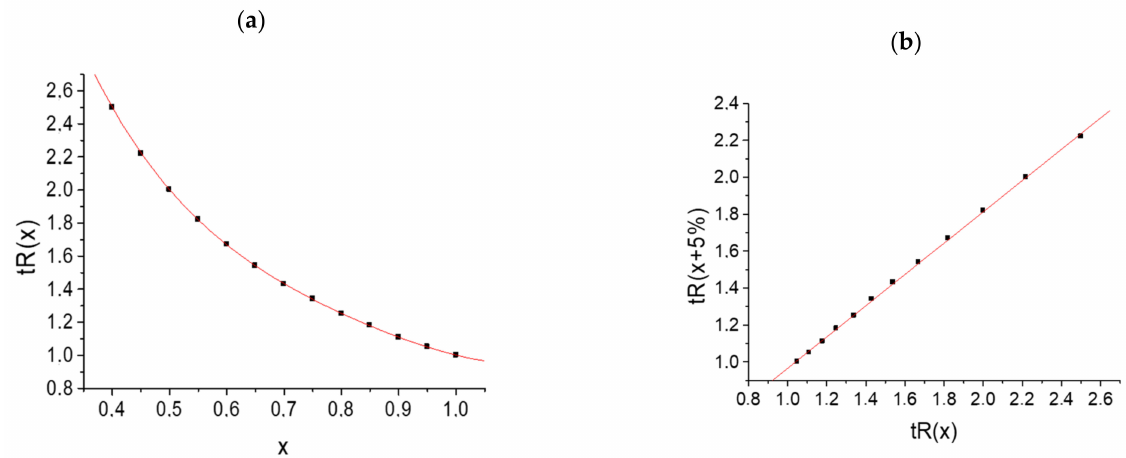
Figure 2. ( a ) Typical nonlinear dependence t R ( x ) (numerical modeling) and ( b ) linear recurrent approximation for the same set of